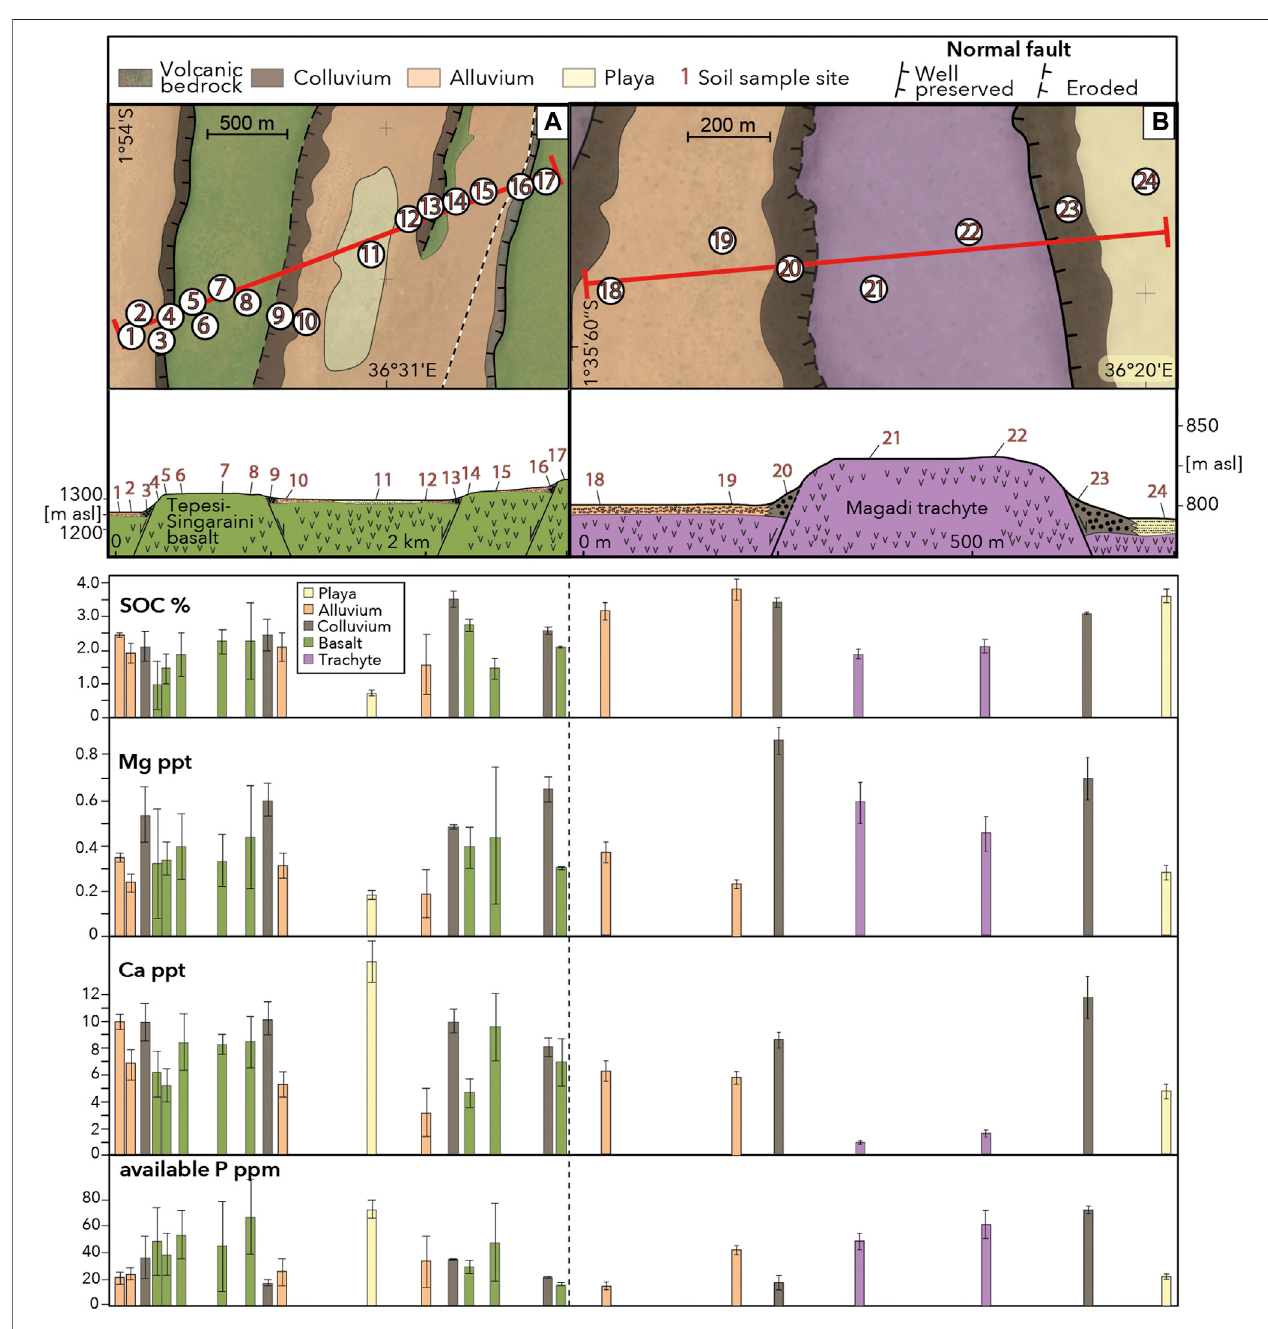
FIGURE 5 | Soil nutrient and SOC variations along two toposequnces crossing (A) the Tepesi-Singaraini basalt plateau, and (B) the Magadi trachyte plateau. Red lines depict the locations of topographic pro fi les; numbers represent locations of a soil sampling site that usually consists of 3-5 individual soil samples; colored bars represent differences in parent